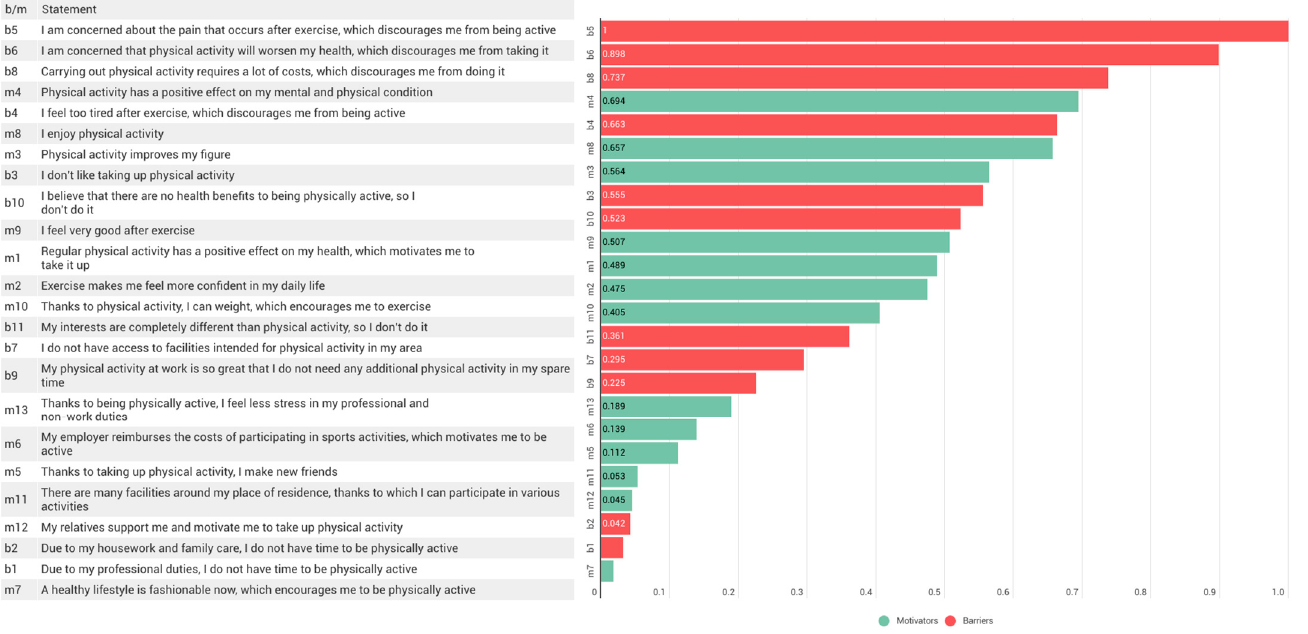
Figure 2. The importance of each predictor in group classification; m/b: motivator or barrier.